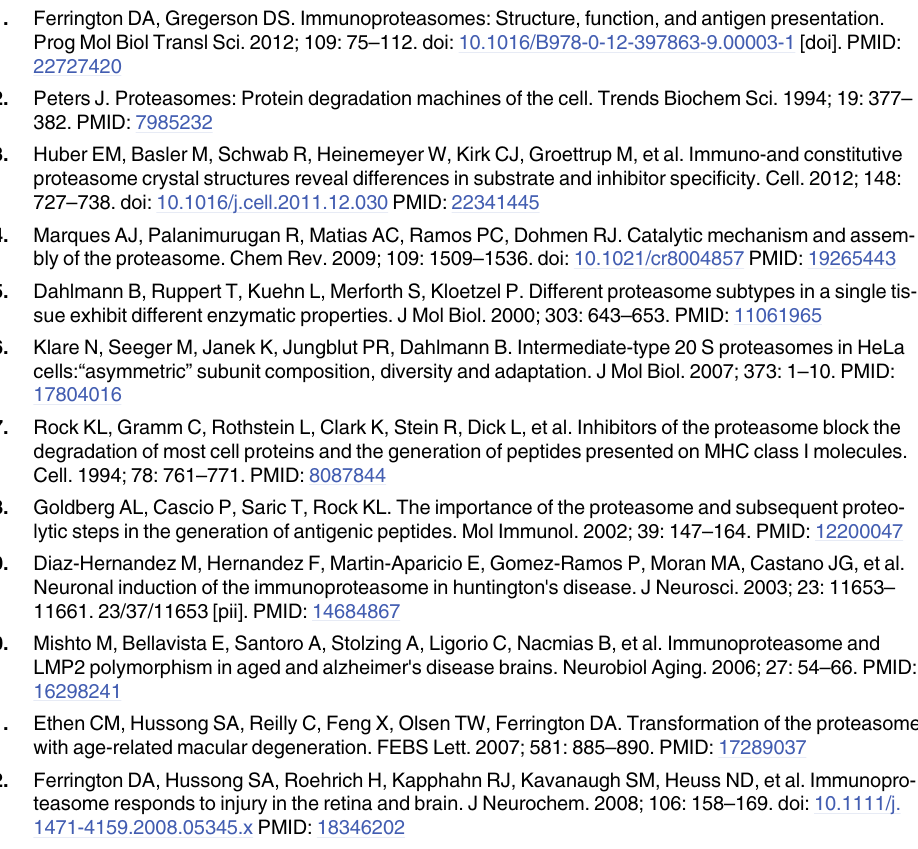
S2 Fig. Ganglion Cell Counts per Total Nuclei in the GCL. Summary of the percent of gangli- on cells per total nuclei (GC/nuclei) in the GCL of control mice and following ONC from WT, L2, and L7M1 mice. Results are the mean ± S.E. of 4 – 5 mice/group. ( (cid:3) , p (cid:1) 0.05 by one-way ANOVA with Dunnett ’ s post-test compared to each cell line ’ s ‘ control ’ values). S3 Fig. Representative Western Blot Data from Fig 6. Protein was isolated from WT, L2, or L7M1 RPE cells after IGF-1 stimulation. Protein MW: PTEN (54kDa), pAkt (60kDa), Akt (60kDa), p-S6K1 (70 kDa), S6K1 (70 kDa). Background ‘ non-specific ’ bands are indicated ( (cid:3)